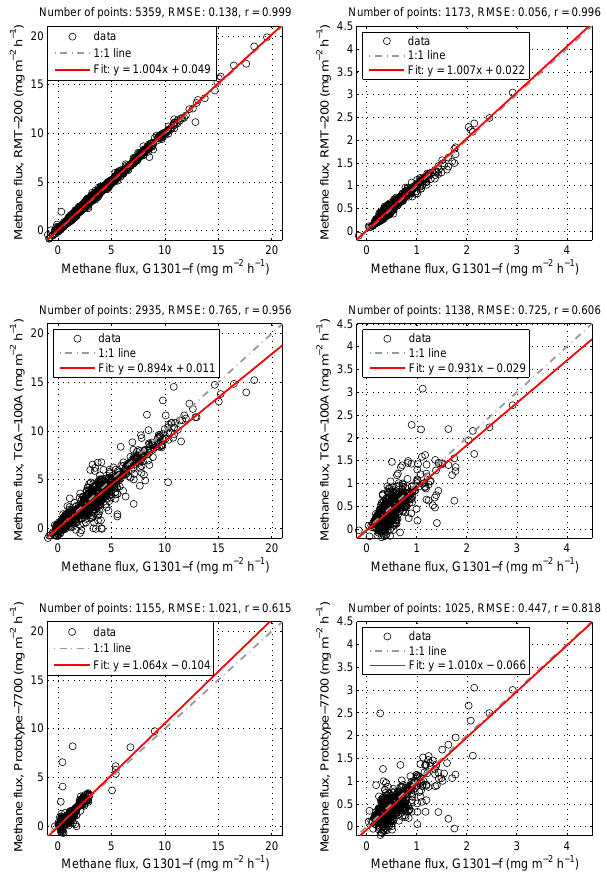
Fig. 9. Scatter plots of methane flux measured with different gas analyzers. Only periods when amount of spikes in a half an hour exceeded 100 were discarded. Number of points in the figure, root- mean-square error and correlation coefficient are given above each figure, respectively. Figures on the left show all the available data and figures on the right are otherwise similar, except data was se- lected only from period 17 May–17 April. During this period all the instruments were working simultaneously and methane flux was on average 0.5mgm − 2 h − 1